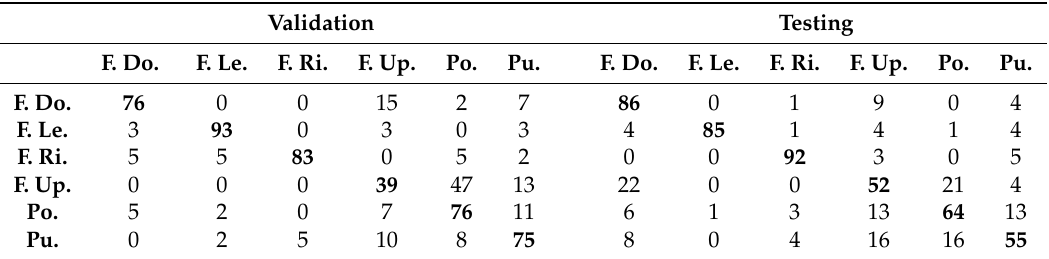
Table 7. Confusion matrices of our multi-stream approach. Rows represent the accuracy (%) of the predictions.